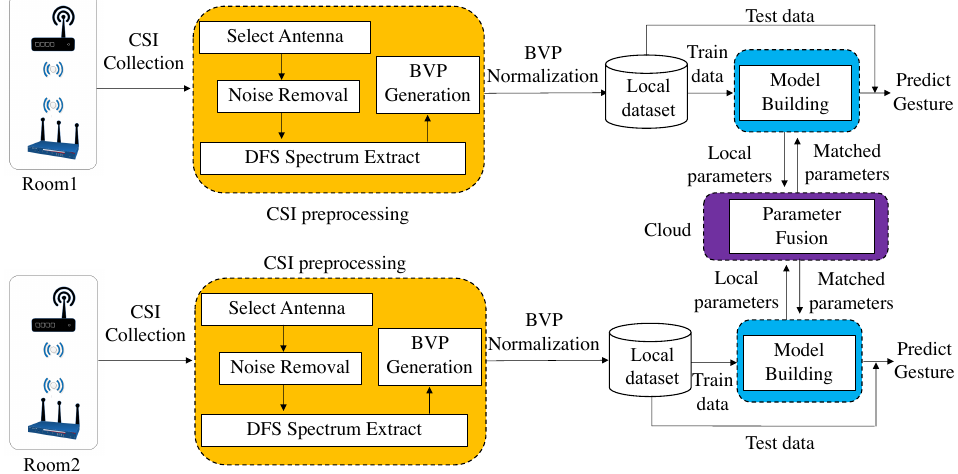
Figure 4. WiMA system